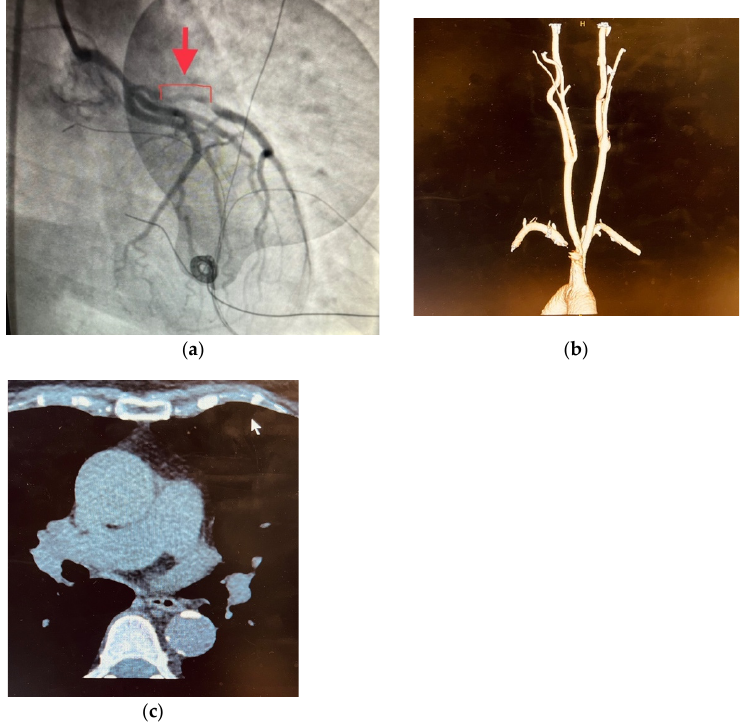
Figure 1. ( a ) Cardiac catheterization showing the dissection of the proximal left anterior descending artery of patient KC. Cardiac catheterization conveying the dissection of the distal left main coronary artery and the proximal LAD (arrow). ( b ) CTA neck of patient KC. CTA of KC showing FMD involving the distal left internal carotid artery (arrow). There is a focal smooth short segment enlargement of the distal left cervical internal carotid artery. ( c ) CT chest of patient MC. CT of MC showing a mildly aneurysmal ascending aorta, measuring 4 cm.